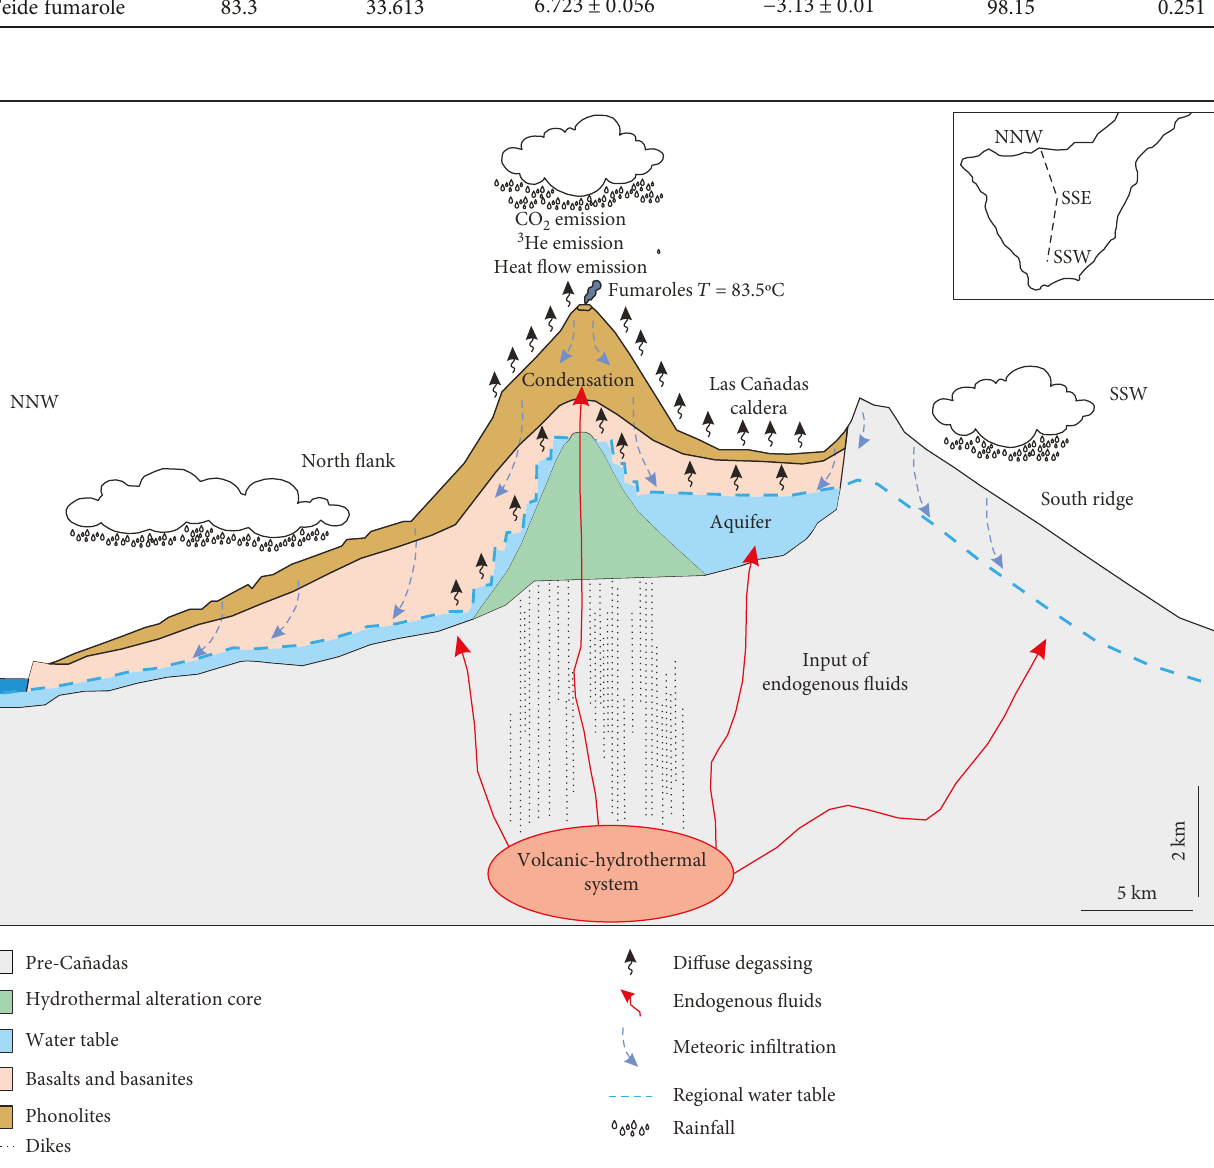
Figure 6: Hydrogeological model of Las Cañadas aquifer in the island of Tenerife. Fluid transport from the volcanic-hydrothermal system to the atmosphere is shown. Modi fi ed from Marrero-Díaz et al.